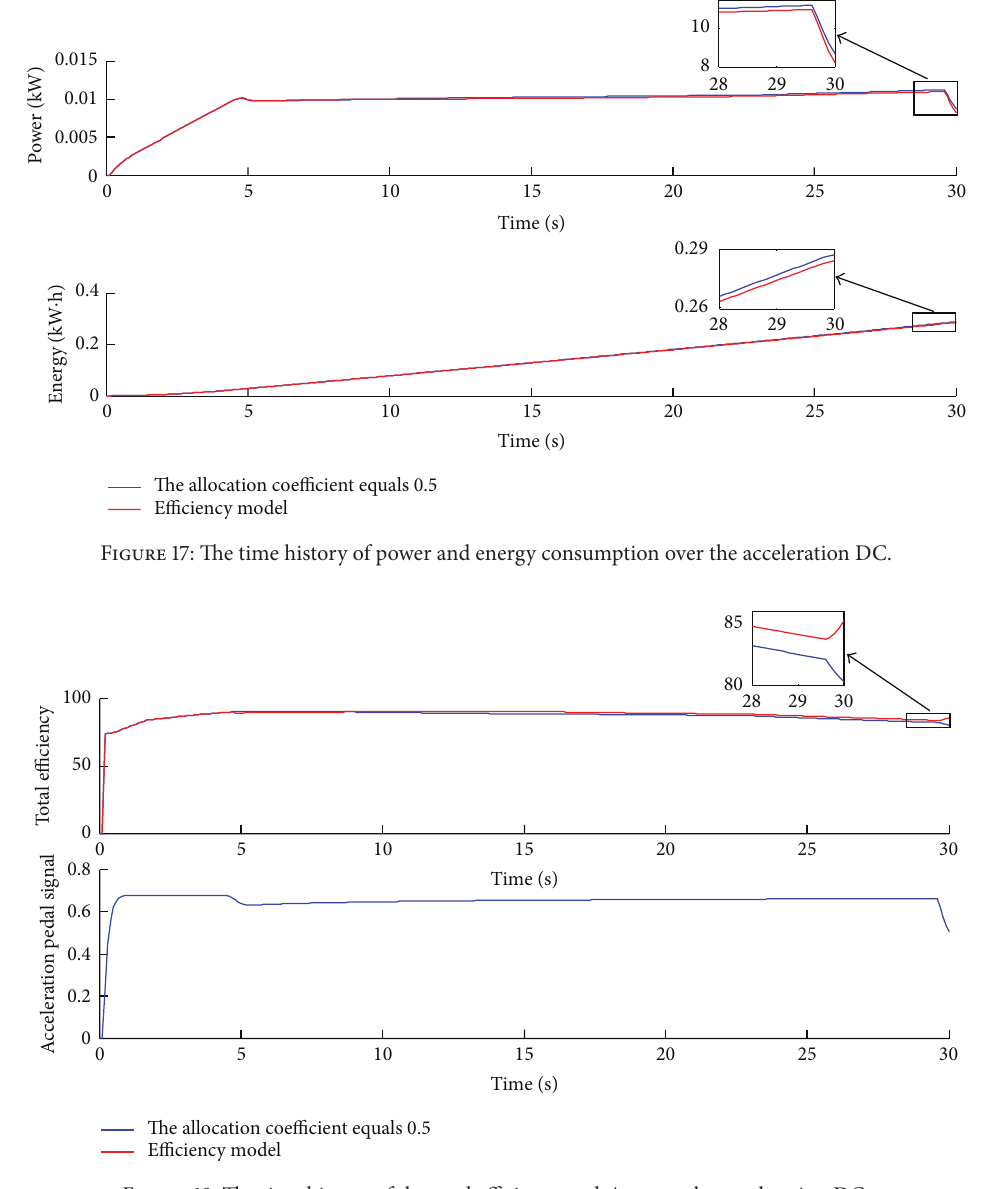
over the acceleration ps